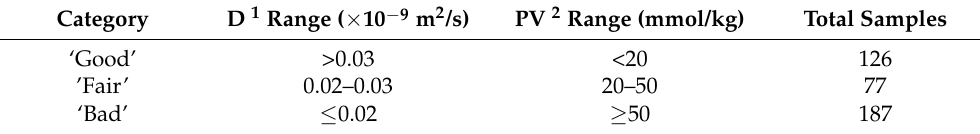
Table 1. Criteria for dividing oil samples into the three categories ‘Good’, ‘Fair’, and ‘Bad’. Category D 1 Range ( × 10 − 9 m 2 /s) Total Samples ‘Good’ >0.03 ’Fair’ 0.02–0.03 ‘Bad’ ≤ 0.02 ≥ 50 187 1 D = Diffusion coefficient. 2 PV = Peroxide